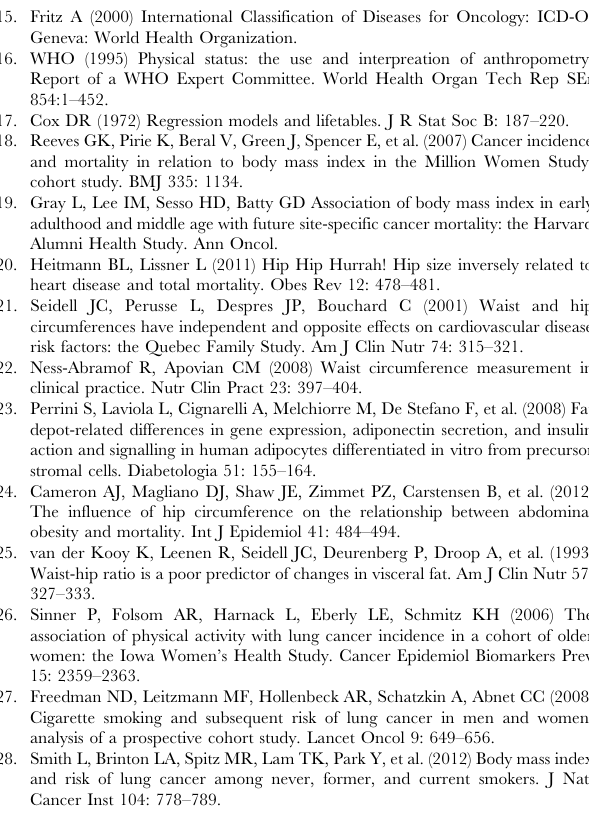
Table S1 Pearson correlations between anthropometric measures in the NIH-AARP Diet and Health